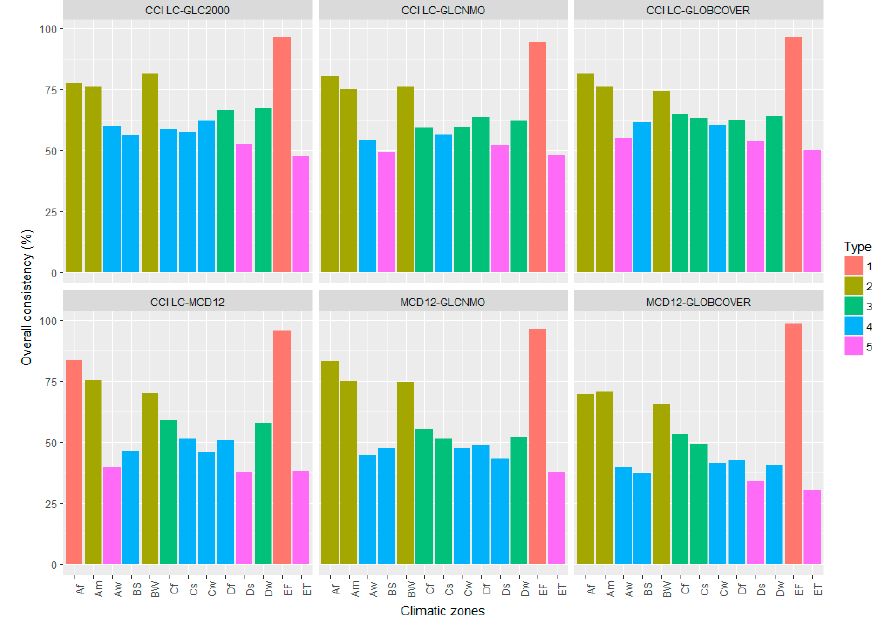
Figure 5. Overall consistency of climatic zones. Different letters represent different climatic zones including 13 areas: Af for equatorial rainforest and full humid, Am for equatorial monsoon, Aw for equatorial savannah, BW for desert climate, BS for steppe climate, Cs for warm temperate climate with dry summer, Cw for warm temperate climate with dry winter, Cf for warm temperate climate and fully humid, Ds for snow climate with dry summer, Dw for snow climate with dry winter, Df for snow climate and fully humid , ET for tundra climate, and EF for frost climate. Different colors or numbers represent different classification results from the natural-breaks method: The lower the number, the higher the overall consistency.